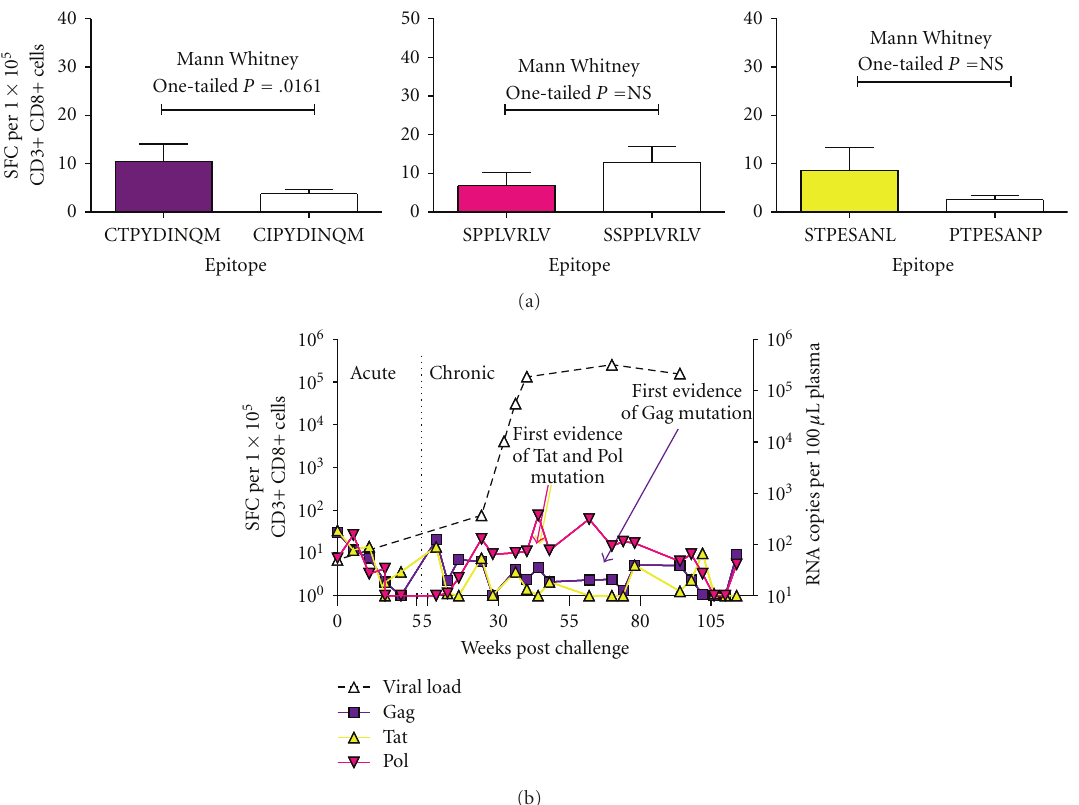
Figure 2: Viral Evolution in an Animal with Known Protective Mamu Alleles. (a) Comparison of IFN- γ ELISPOT values for the vaccinated, Mamu A ∗ 01 + NP animal 16040 before or after the Mamu A ∗ 01 -restricted Gag CTPYDINQM to CIPYDINQM, Tat STPESANL to PTPESANP, and Pol STPPLVRLV to SSPPLVRLV mutations. Statistical analysis was performed using the Mann Whitney test. (b) NASBA viral loads and IFN- γ ELISPOT results for all three epitopes were plotted to determine the e ff ects of mutations on the control of viral